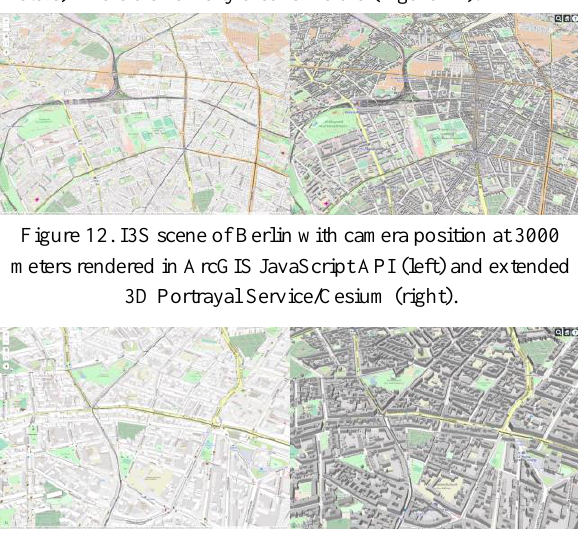
Figure 13. I3S scene of Berlin with camera position at 1000 meters rendered in ArcGIS JavaScript API (left) and extended 3D Portrayal Service/Cesium (right).